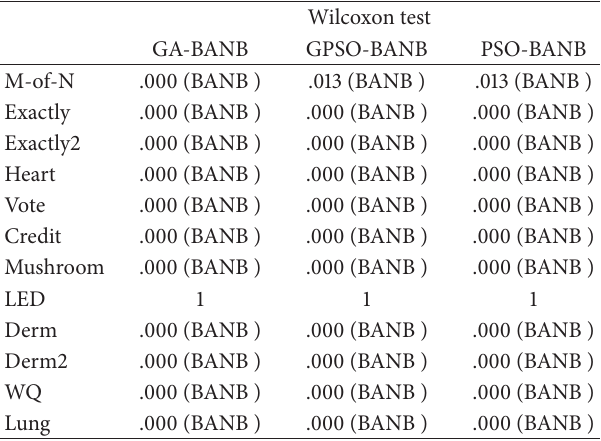
Table 3: Wilcoxon test